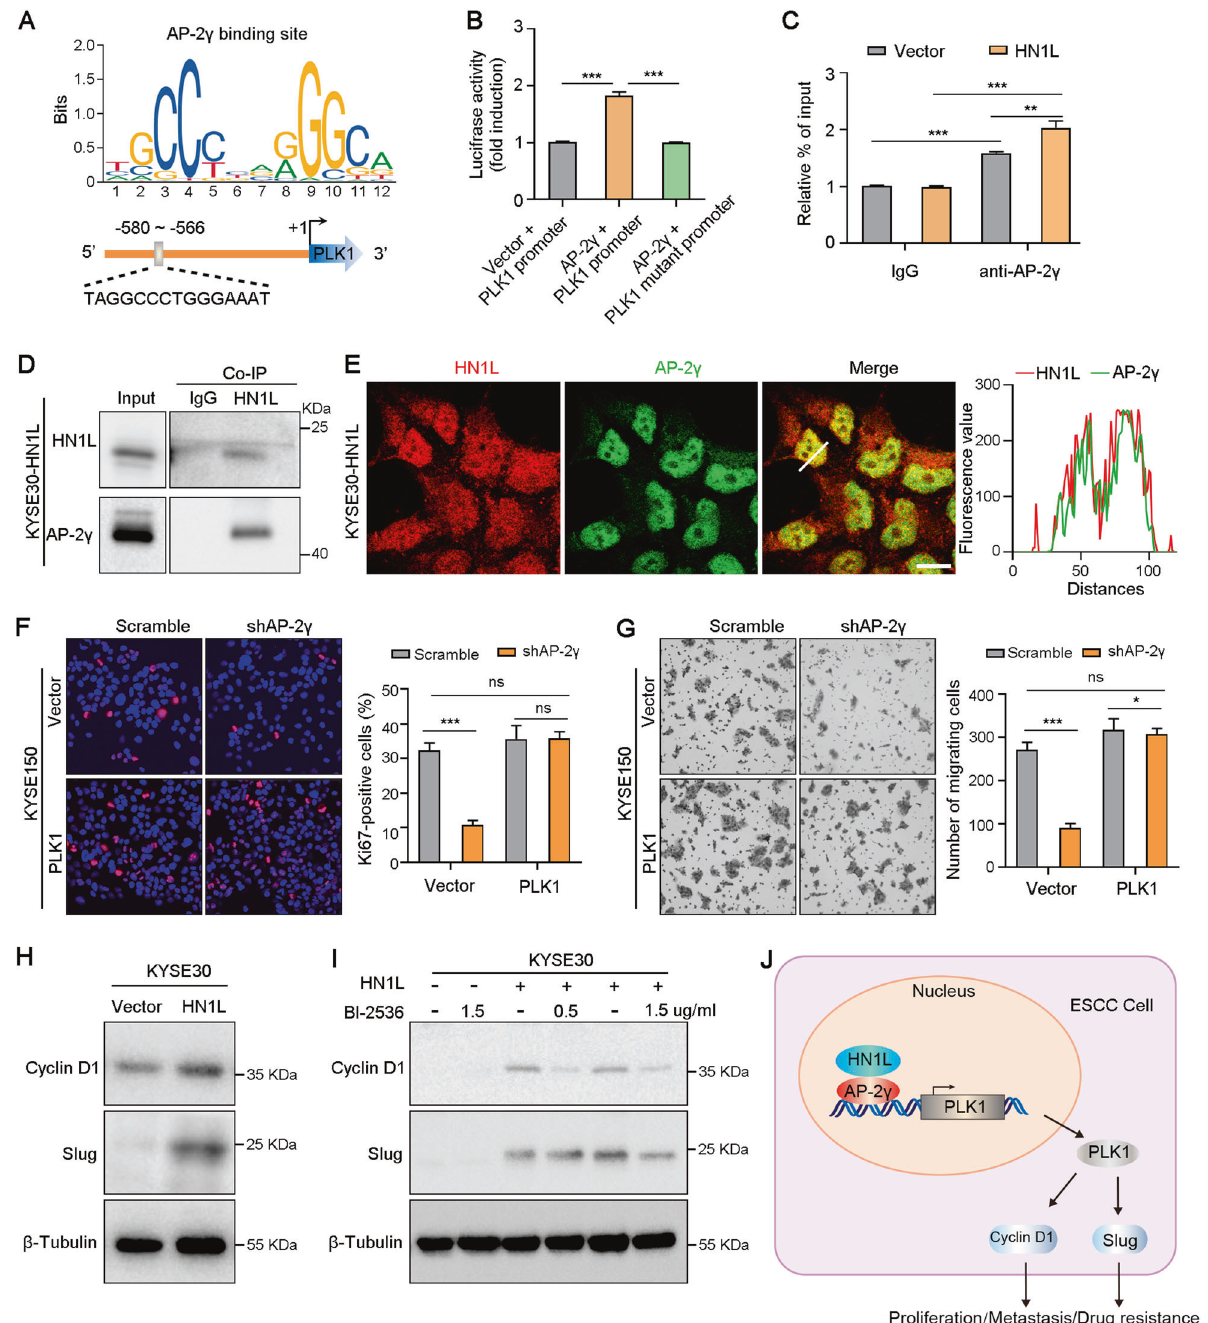
Fig. 6 HN1L-AP-2 γ -PLK1 axis promotes ESCC progression via up-regulation of Cyclin D1 and Slug. A AP-2 γ transcriptional binding sites in the PLK1 gene promoter. B Luciferase reporter assay showed that HN1L transcriptionally up-regulated PLK1 expression by activating AP-2 γ in KYSE30 cells. C ChIP-qPCR assay to validate that AP-2 γ bound to the promoter of PLK1 in Vector or HN1L-transfected KYSE30 cells. D Co-IP was performed with HN1L antibody on KYSE30- HN1L cells. E Double IF staining with antibodies against HN1L and AP-2 γ in KYSE30- HN1L cells. F , G The rescue experiments on cell proliferation ( F ) and metastasis ( G ) mediated by PLK1 were performed in AP-2 γ -silenced KYSE150 cell. H The protein levels of Cyclin D1 and Slug in KYSE30 cells after HN1L overexpression were analyzed with western blotting. I The protein levels of Cyclin D1 and Slug in KYSE30 cells after HN1L overexpression or PLK1 inhibitor BI-2536 treatment were analyzed with western blotting. J The diagram shows that HN1L enhances PLK1 expression by activating transcription factor AP-2 γ , which further increases Cyclin D1 and Slug expression levels, promoting ESCC cell proliferation, metastasis and drug resistance. In B , C , E , F , data are presented as the mean ± SD; two- sided Student ’ s t test; * P < 0.05, ** P < 0.01, *** P < 0.001, ns: no signi fi cant AP-2 γ -silenced ESCC cells (Figs. 6F, G and S6E). These evidences con fi rmed that AP-2 γ knockdown resulted in the down-regulation indicated that HN1L increased PLK1 expression by activating AP-2 γ . of PLK1 at mRNA and protein levels (Fig. S6C, D). Rescue experiments showed that PLK1 overexpression rescued the growth rate, migration ability and chemotherapy resistance of